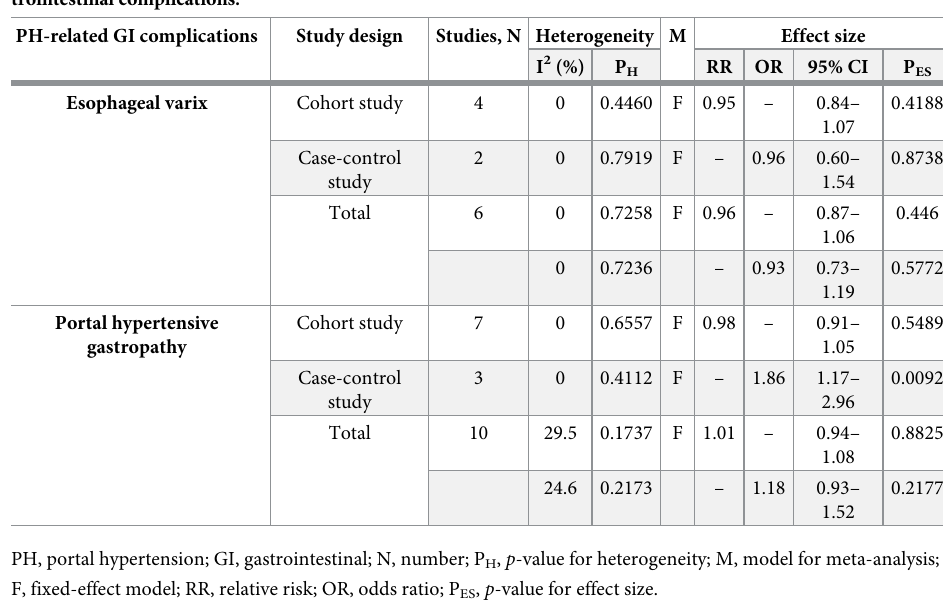
Table 2. Meta-analysis of relationship between Helicobacter pylori infection and portal hypertension-related gas- trointestinal complications.